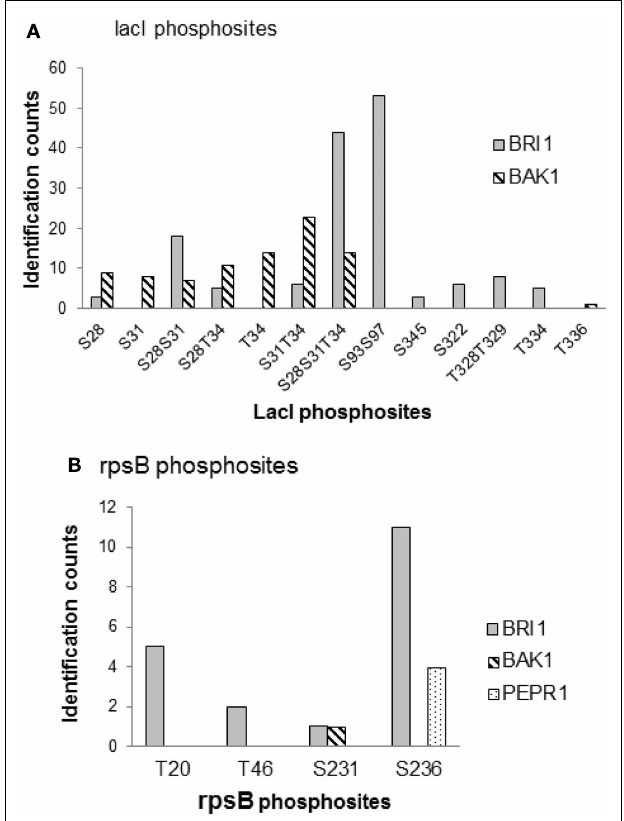
FIGURE 7 | Comparison of kinase specificities for BRI1, BAK1, and PEPR1 with lactose operon repressor (lacI) or 30S ribosomal protein S2 (rpsB) as substrate. (A) Abundance of specific phosphopeptides of lacI and (B) ribosomal protein rpsB that were transphosphorylated by the indicated protein kinases expressed in E. coli cells.The relative abundance of each phosphopeptide species was based on the spectral counts in the mass spectrometry identification, and reflects the sum of four independent experiments involving twoTiO 2 and two IMAC (Fe 2 + ) enrichment steps. Note that there was no evidence for phosphorylation of lacI by PEPR1, or rpsB by PEPR1 or CDPK β , and that phosphopeptides are identified using the single letter abbreviations for Ser (S) andThr